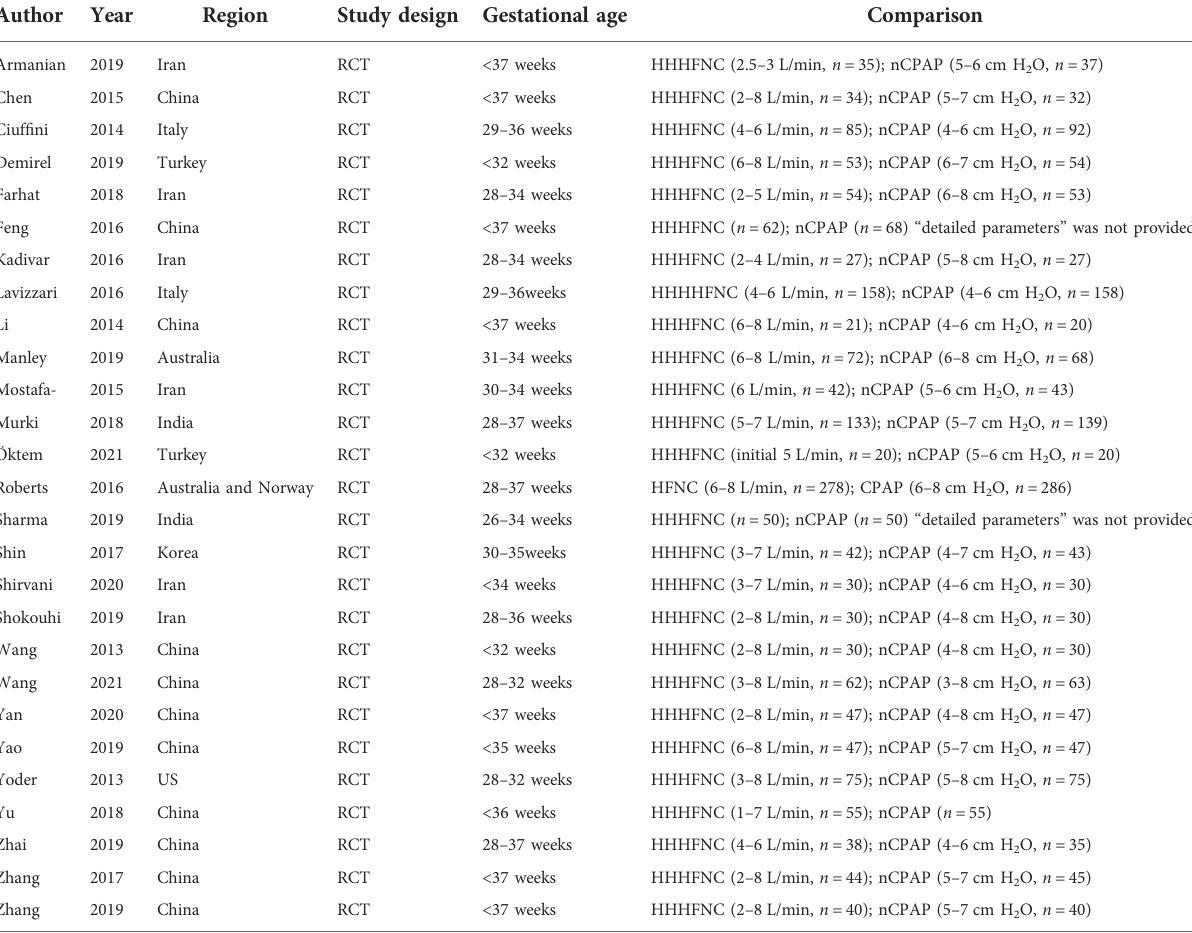
TABLE 1 Characteristics of included